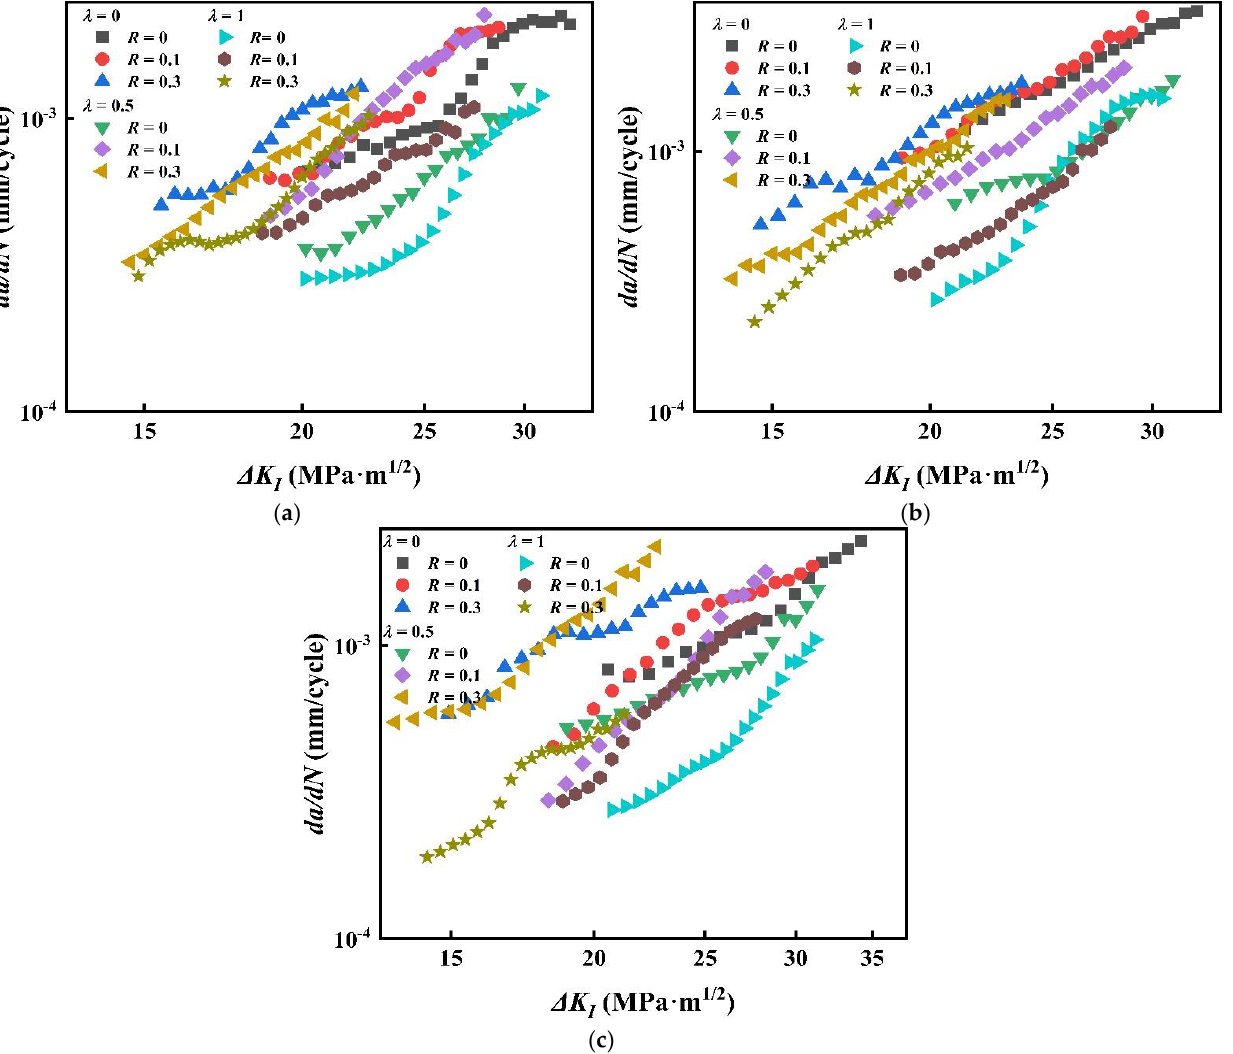
Figure 14. The relationship between ∆ K I and da / dN, based on the Paris model. ( a ) β = 90 ◦ ( b ) β = 60 ◦ ( c ) β = 45 ◦